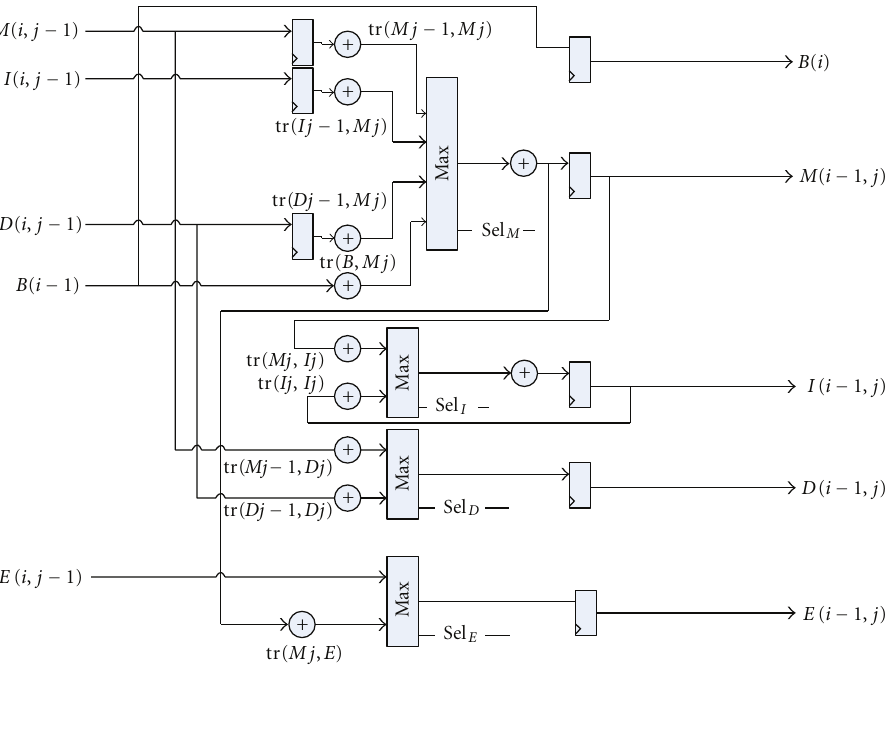
Figure 8: Score stage for the architecture’s